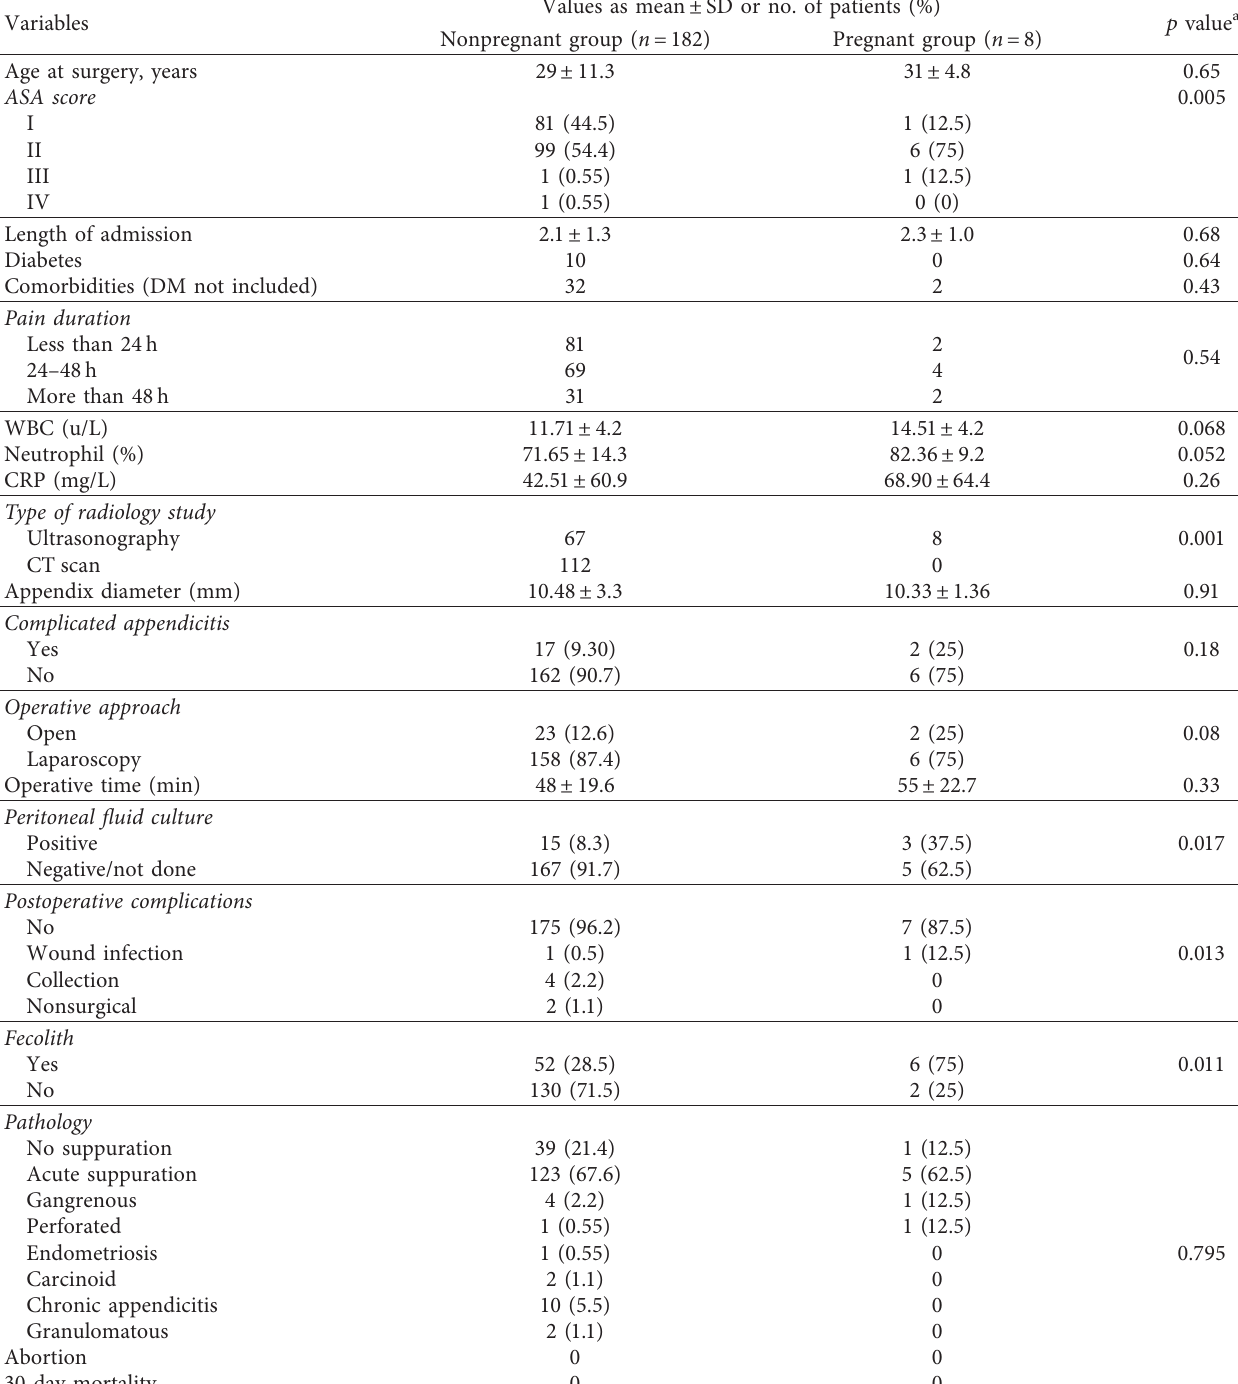
Table 1: Demographics and clinicopathological features of the study patients according to pregnancy status. Values as mean ± SD or no. of patients Variables